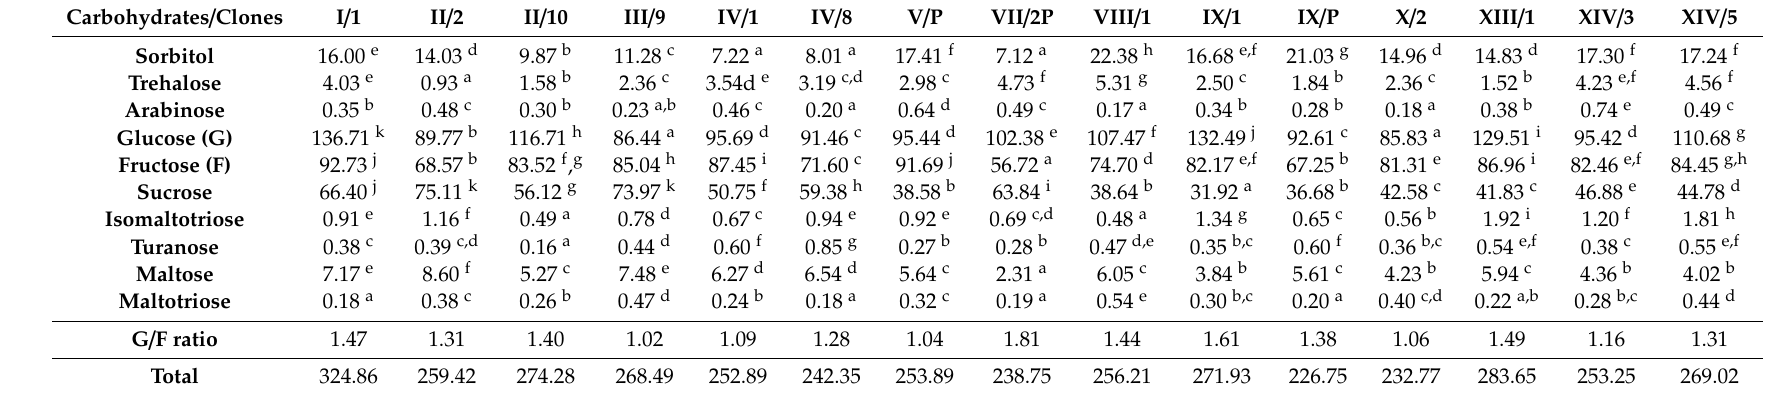
Table 3. The average (2015 and 2016) contents of carbohydrates (mg / g), in pollen of 15 ‘Oblaˇcinska’ sour cherry clones. Carbohydrates /